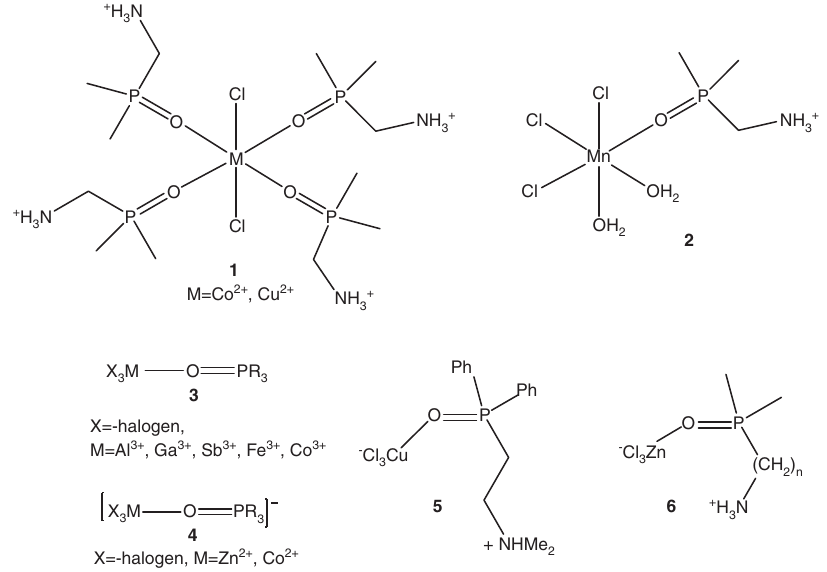
Scheme 1: Schematic drawings of dpma H + -containing complexes of Cu(II) ( 1 ), Co(II) ( 1 ) and Mn(II) ( 2 ) and some trihalogenido complexes which furthermore coordinate to a phosphoryl moiety ( 3 – 6 ).